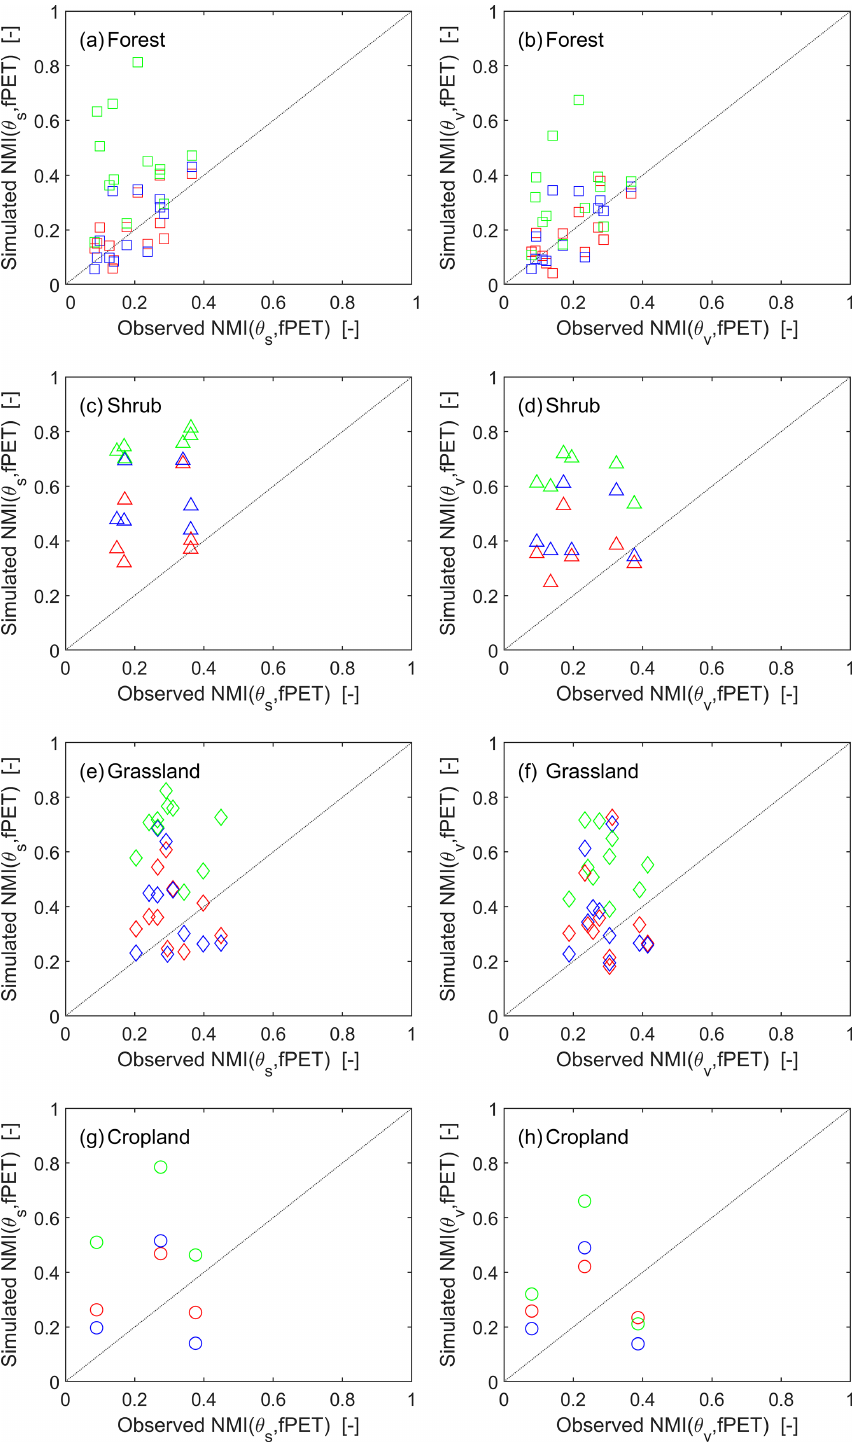
Figure 4. Scatterplot of LSM- and GLEAM-based (a, c, g, e) NMI( θ s , fPET) and (b, d, f, h) NMI( θ v , fPET) results versus AmeriFlux observations. Red symbols represent simulations from NOAHMP36; blue symbols represent simulations from CLSM2 and green symbols represent GLEAM